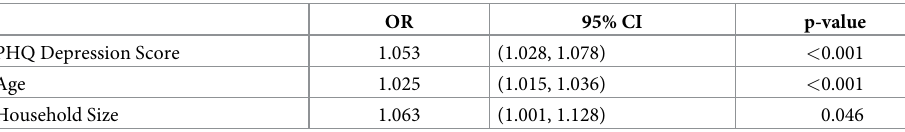
Table 5. Association with multidimensional